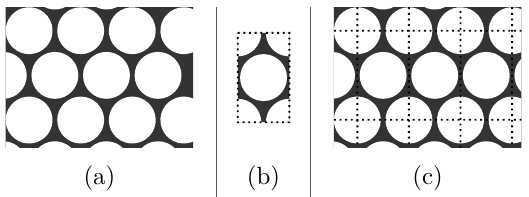
Figure 1. Periodic Unit Cell concept, a) heteroge- neous micro-structure with regular lattice, b) unit cell, c) reconstructed